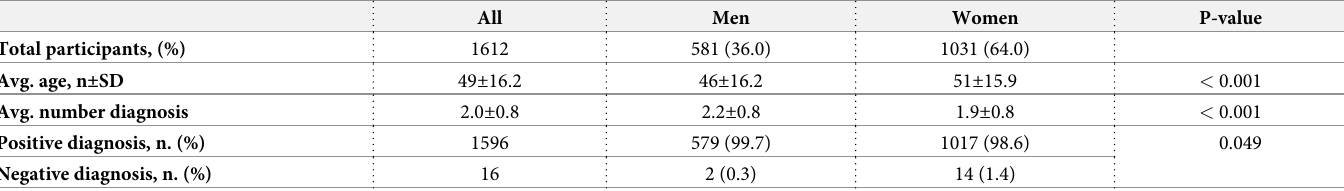
Table 1. General information of participants and number of upper GI endoscopic diagnosis.